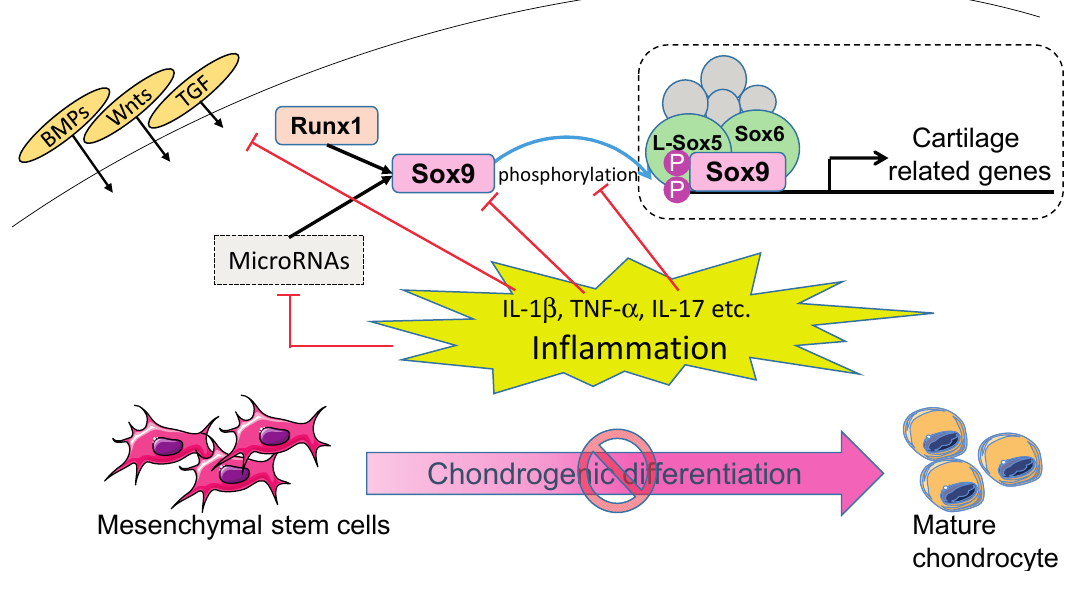
Figure 1. Schematic diagram of the potential role of inflammation on chondrogenic differentiation. Inflammatory mediators, such as IL-1 β , TNF- α , and IL-17, contribute to the inhibition of chondrogenic differentiation of mesenchymal stem cells (MSCs) through several mechanisms. Abbreviation: BMPs, bone morphogenetic proteins; Wnts, wingless-type MMTV integration site family members; TGF, transforming growth factor; Runx, runt-related gene; Sox,